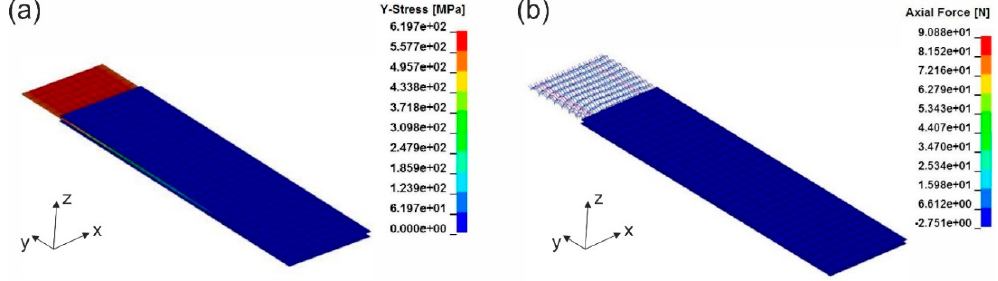
Figure 15. Simulation of friction test for fabric variant 1 with ( a ) macro-scale model and ( b ) meso- scale model.